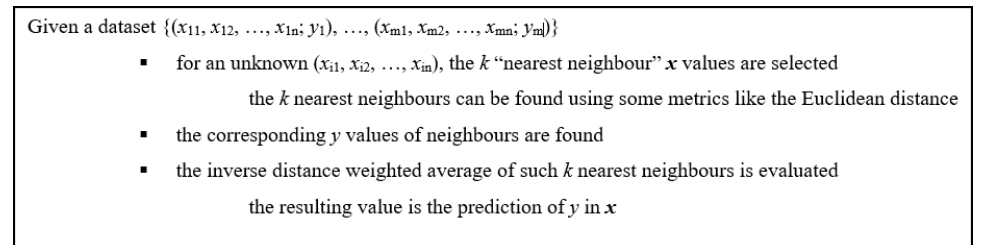
Figure 2. k Nearest Neighbor ( k-NN ) algorithm pseudocode. It is also valid for K-Star , as long as the Euclidean metric is replaced by the entropy metric.